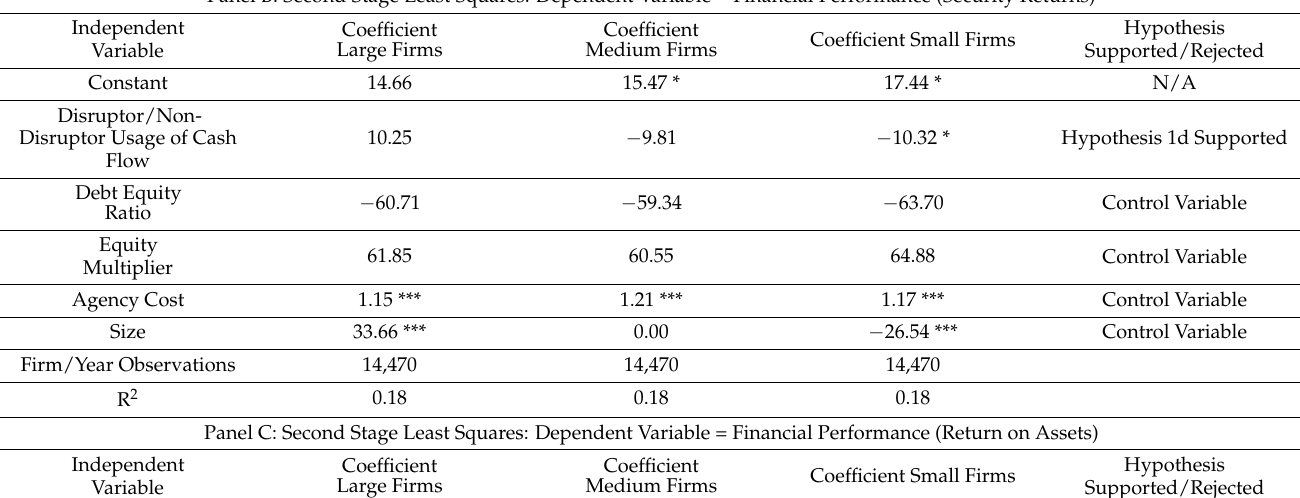
Panel C: Second Stage Least Squares: Dependent Variable = Financial Performance (Return on Assets)